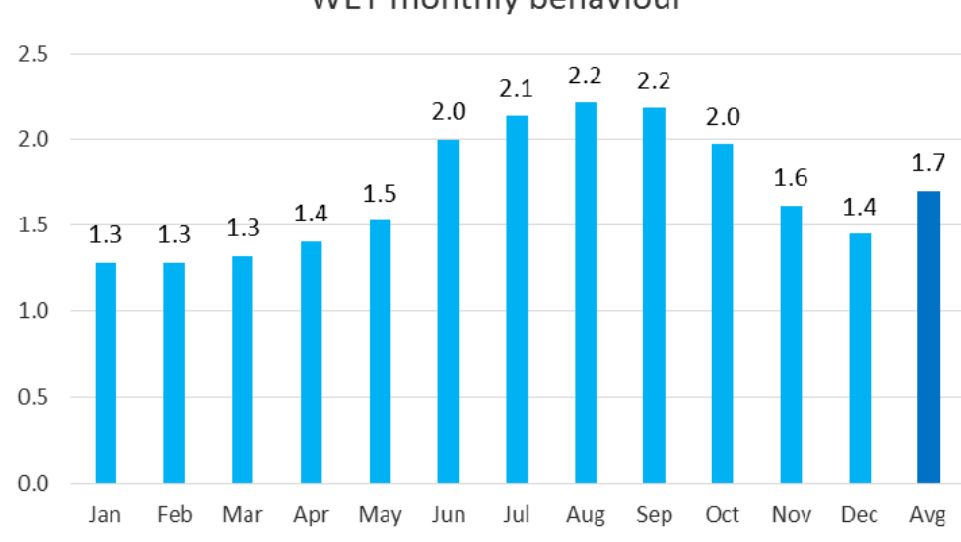
Figure 5. WET calculation for Abu Dhabi climate.